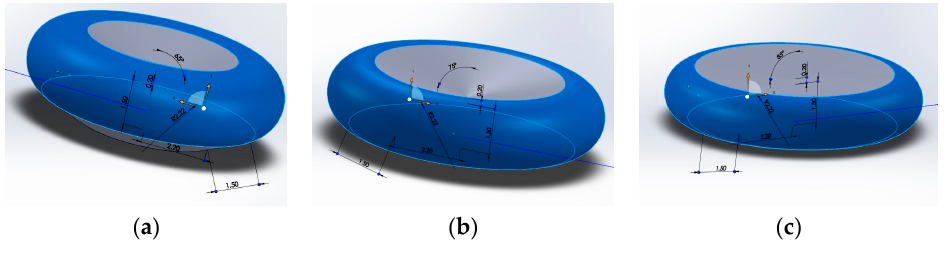
Figure 3. SFL with ( a ) 130°; ( b ) 150° and ( c ) 170° peak intensity angles.